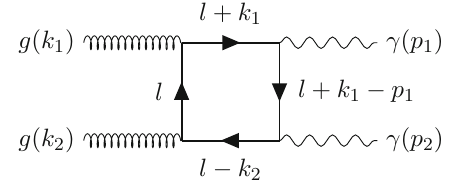
Fig. 1 A representative top-loop diagram contributing to gg → γγ